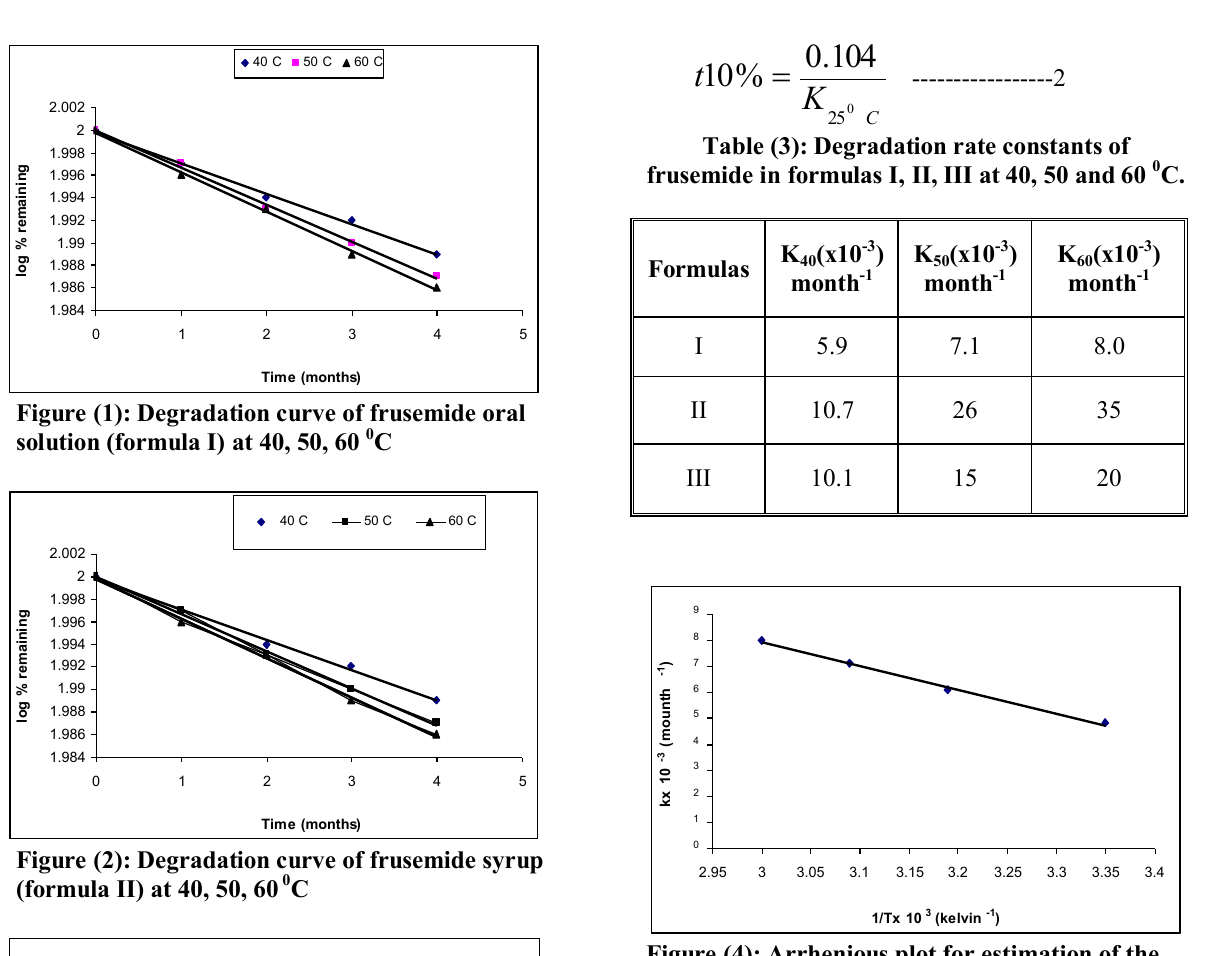
Figure (4): Arrhenious plot for estimation of the expiration date of formula I at 25 0 C.